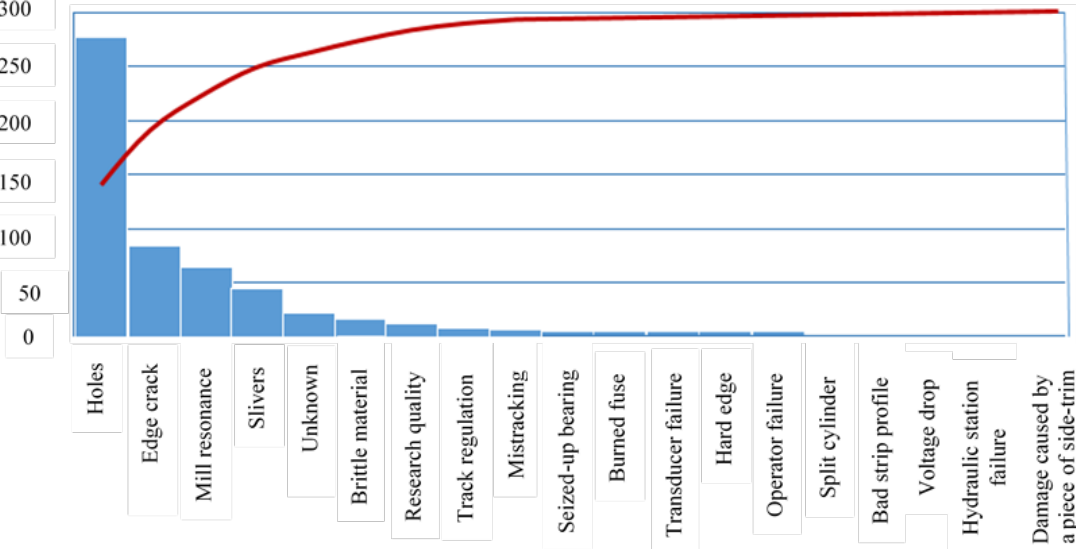
Figure 6. An overview of rupture triggers in steel-strip rolling. In-house database created over a one-year period monitoring strip ruptures in the cold-rolling process on a five-seat tandem.